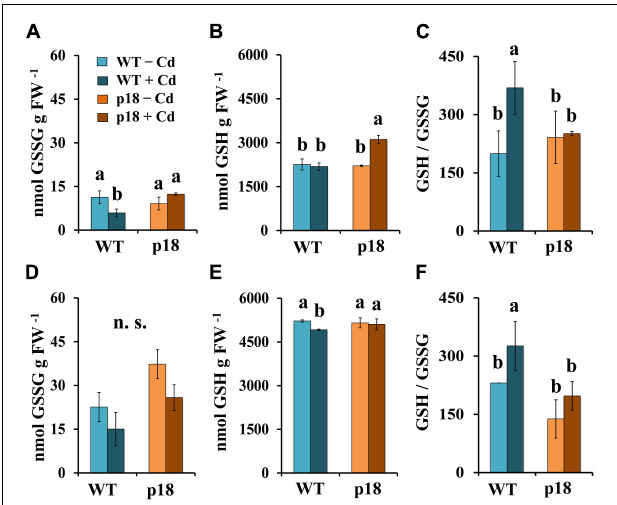
FIGURE 6 | Lipid peroxidation (MDA), superoxide dismutase and catalase activities in M. truncatula WT and p18 roots (A–C) and shoots (D–F) . Plants were grown in pots with 0 or 100 µ M CdCl 2 for 32 days. Bars indicate standard deviation. Different letters denote significant differences, Tukey HSD, p < 0.05, n =